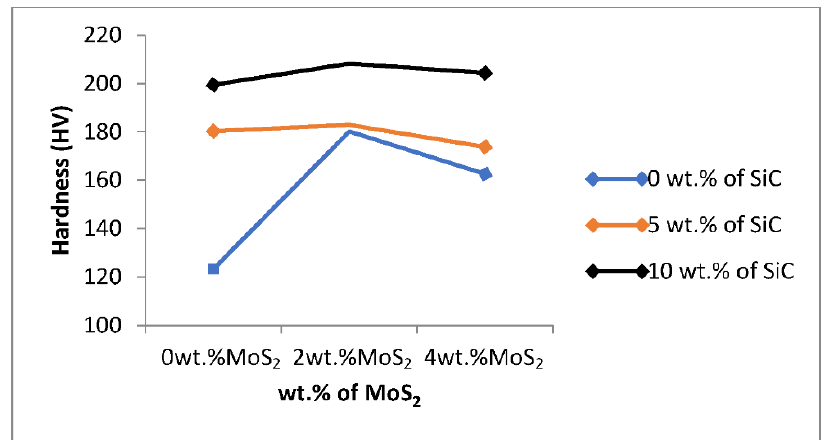
Figure 3. Effect of process parameters on hardness.